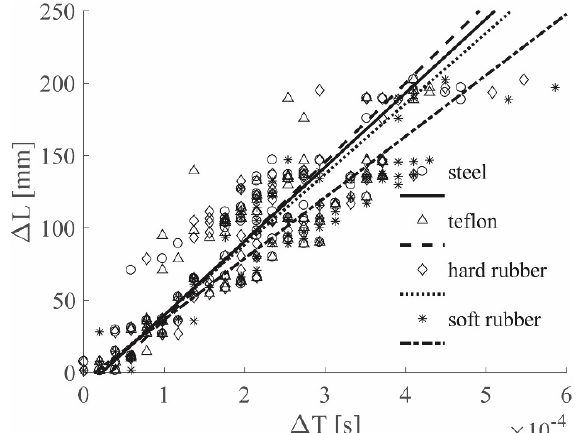
Figure 12. ( Δ L – Δ T ) visual approach results for the PZT sensors, sandwich panel, all tips, filtered with the 0–4912 Hz filter ( a ), 0–2000 Hz filter ( b ) and 0–1689 Hz filter ( c ).